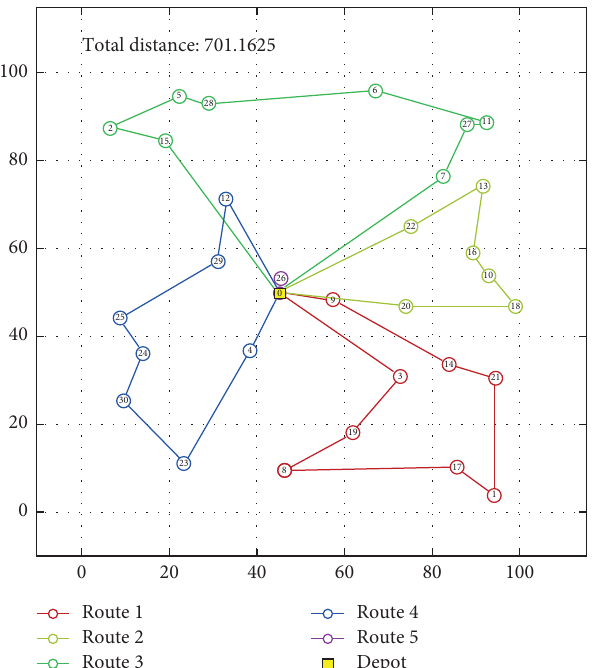
Figure 10: Optimal values obtained by the HSCA after 20 runs in case study 2. Route 1: 0- > customer3- > customer19- > customer8 -